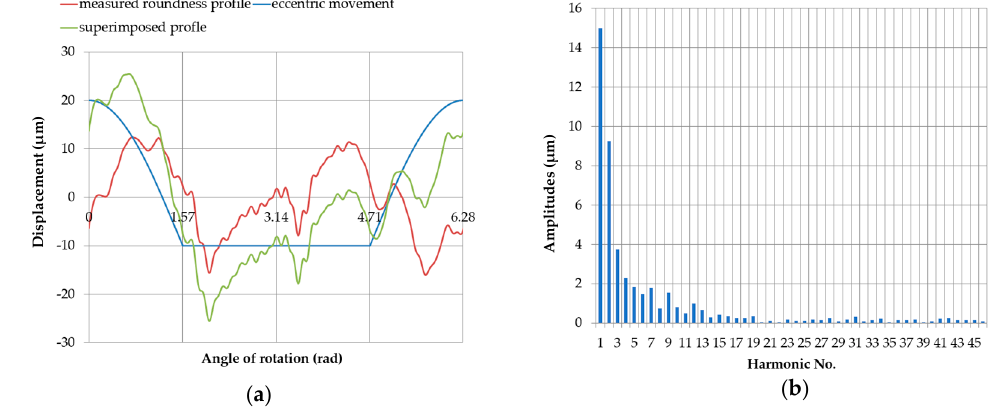
Figure 22. Profile obtained by superimposing the measured roundness profile of journal no. 5—rotated by 60° with respect to the reference profile—onto the profile of the eccentric movement of the center of the measured roundness profile, with the supports set at the same height ( 𝑥 = 0 𝑚𝑚 ); with an eccentricity of the main journal 𝑒 = 0.03 𝑚𝑚 ( a ); discrete amplitude spectrum of the superimposed profile ( b ). Table 9. Amplitudes of the harmonic components for the profile obtained by superimposing the measured roundness profile of journal no. 5—and by rotating it by 60° with respect to the reference profile—onto the eccentric movement profile of the center of the measured roundness profile when the supports were set at the same height ( 𝑥 = 0 𝑚𝑚 ), with an eccentricity of the main journal e = 0.03 mm. Harmonic amplitudes [ μ m]